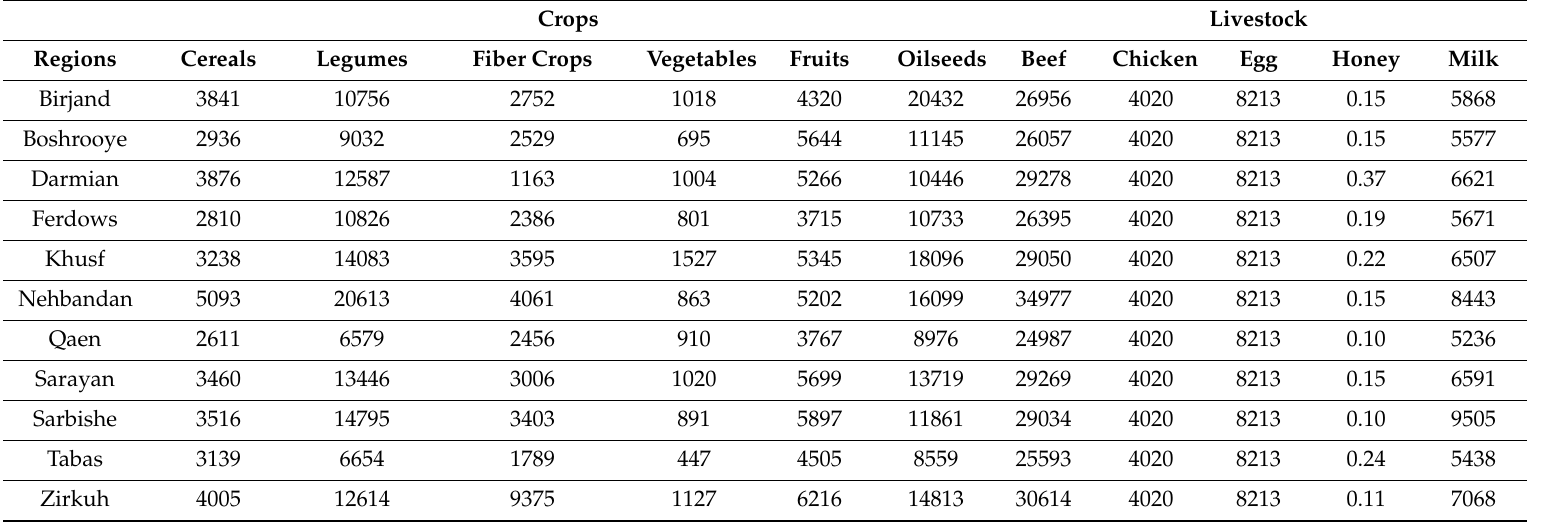
Table 2. Virtual water content of agricultural products in counties (m 3 /